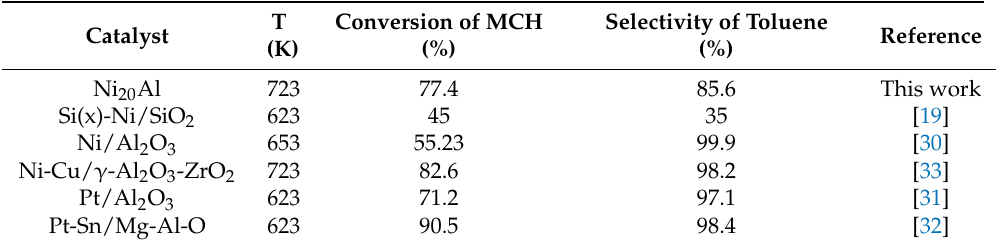
Table 2. Comparison of the performance of the catalyst for dehydrogenation of methylcyclohexane in this work with the results of previous